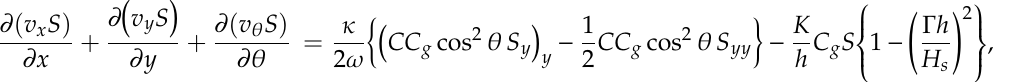
Table 2. Offshore wave conditions and measured data for model validation.